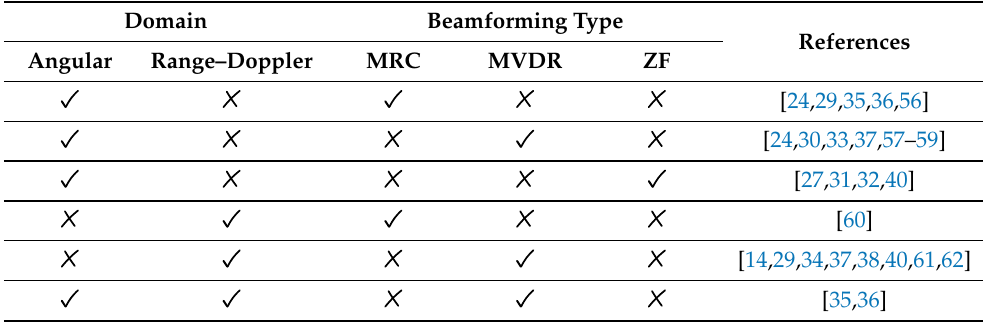
Table 2. Classification of main work on the reference